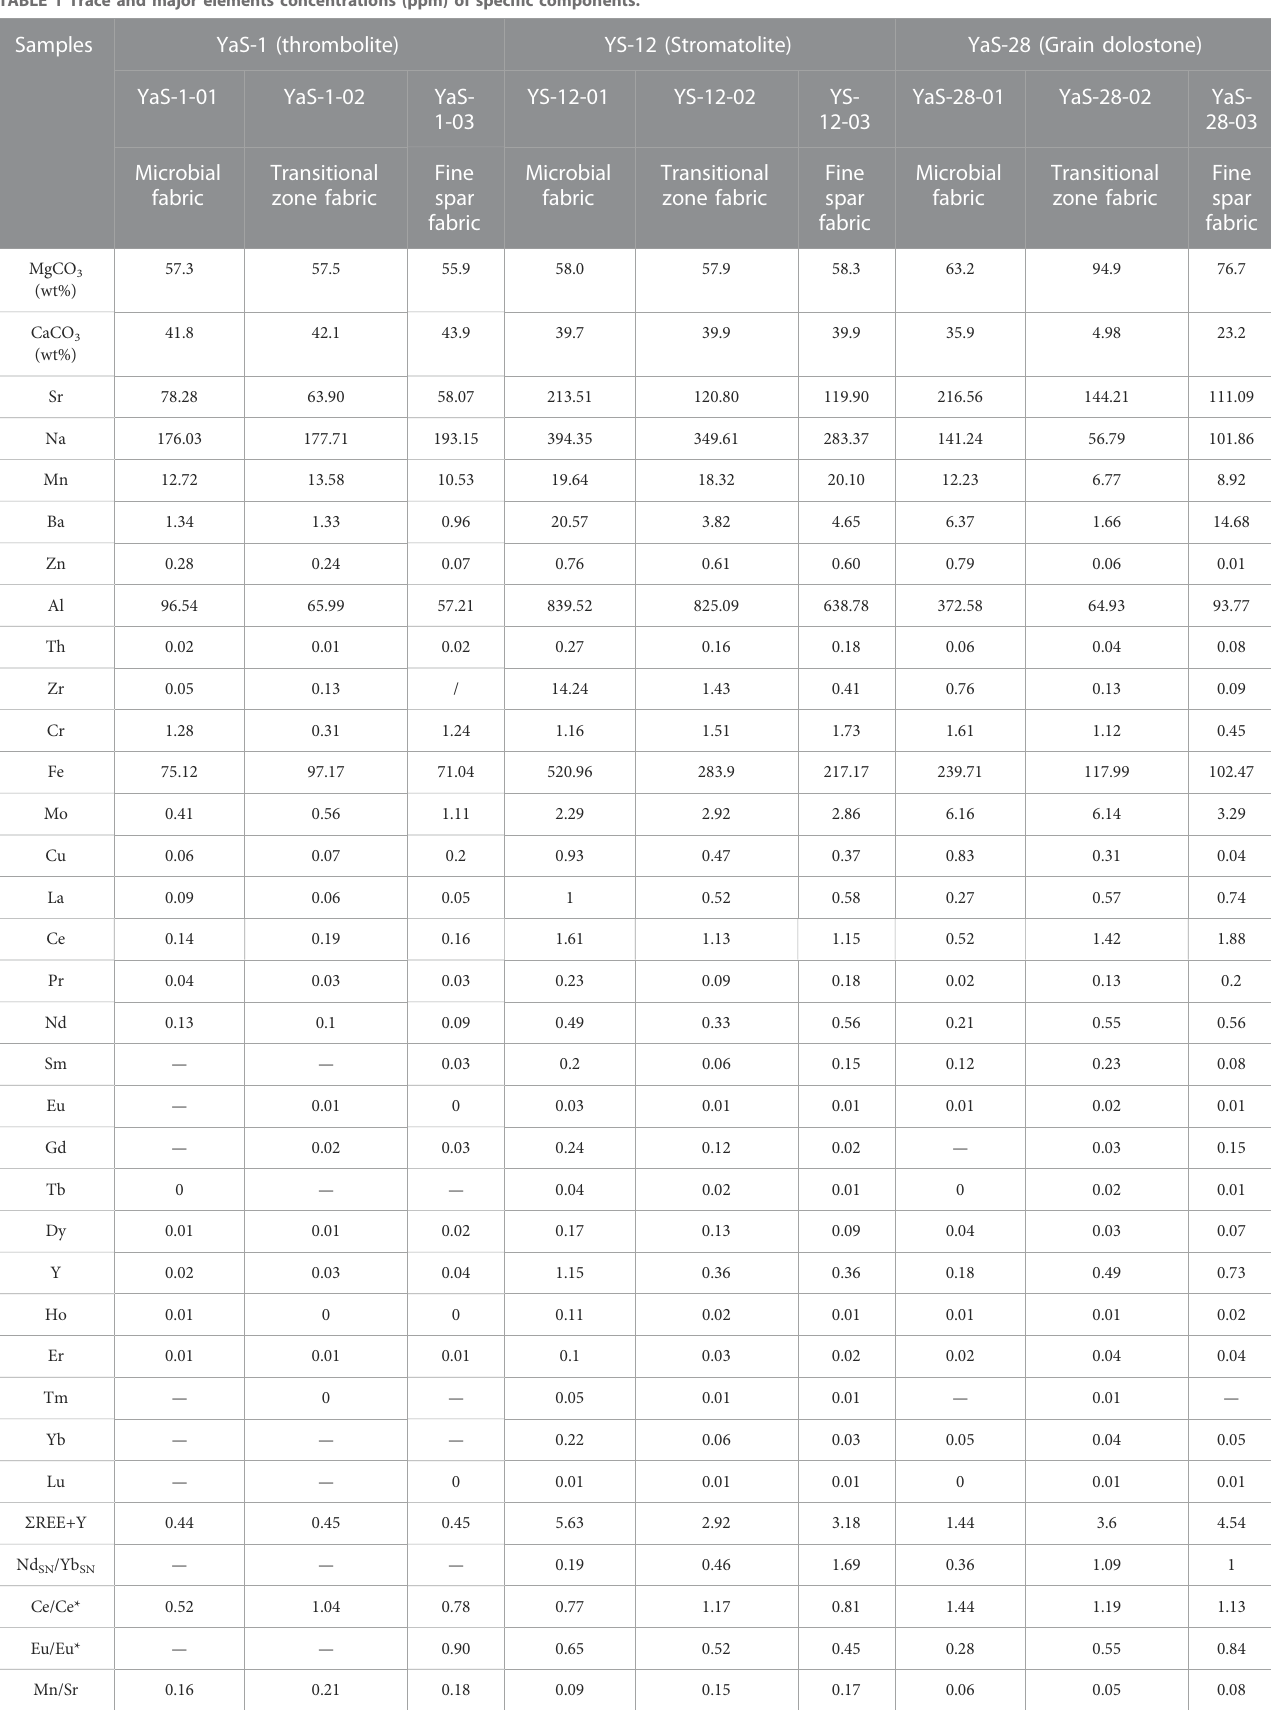
TABLE 1 Trace and major elements concentrations (ppm) of speci fi c components.